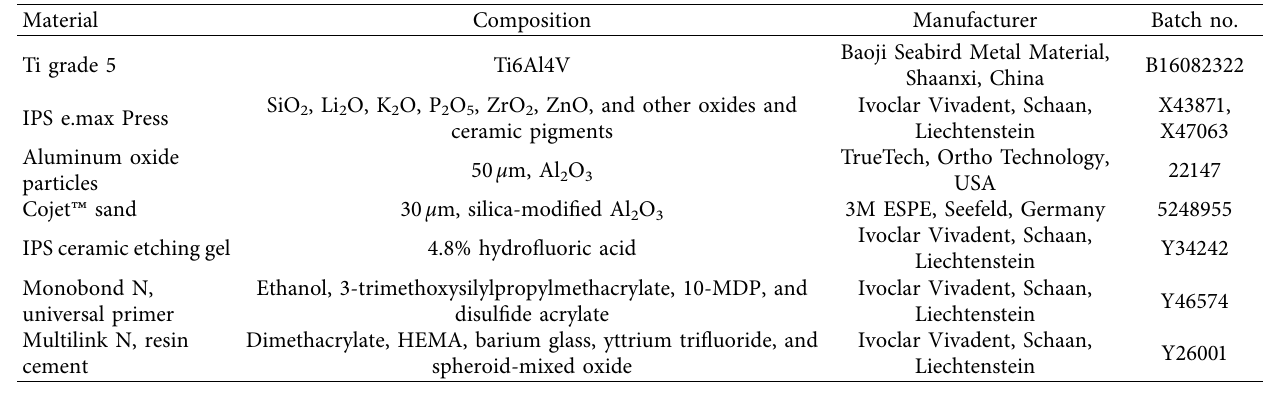
Figure 2: Gold-colored anodized Table 1: Materials used in this study.